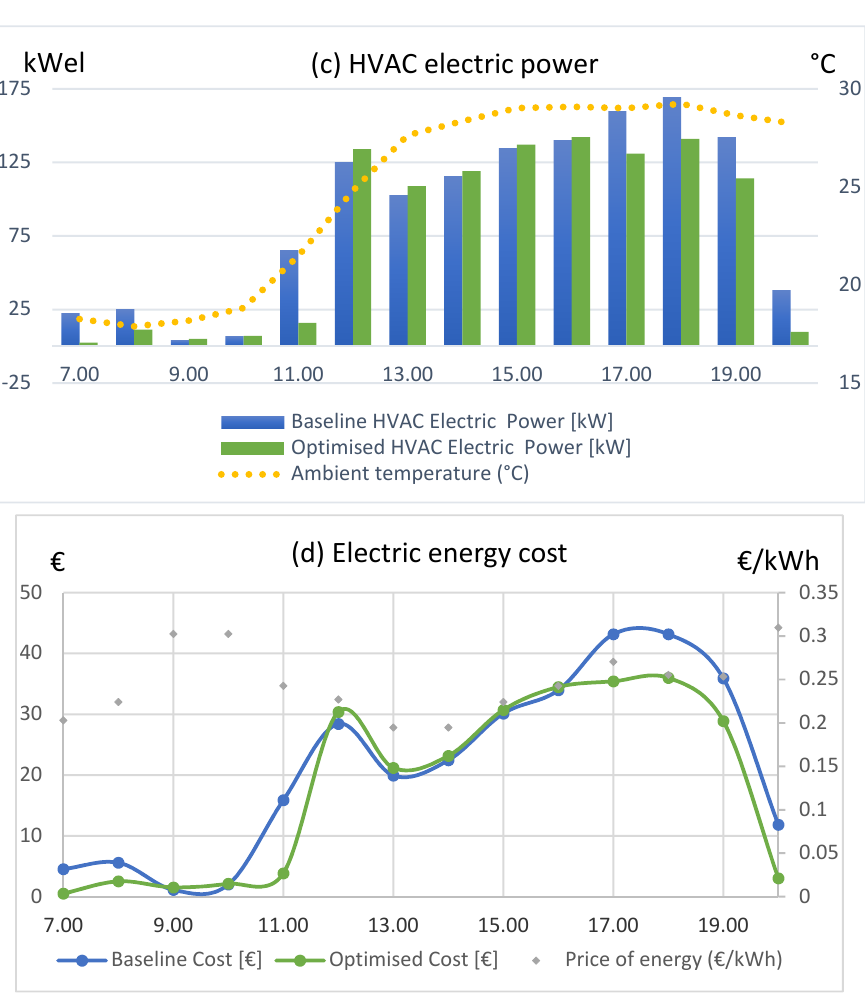
Figure 7. GA HVAC optimization results for 21 September 2018 (autumn).